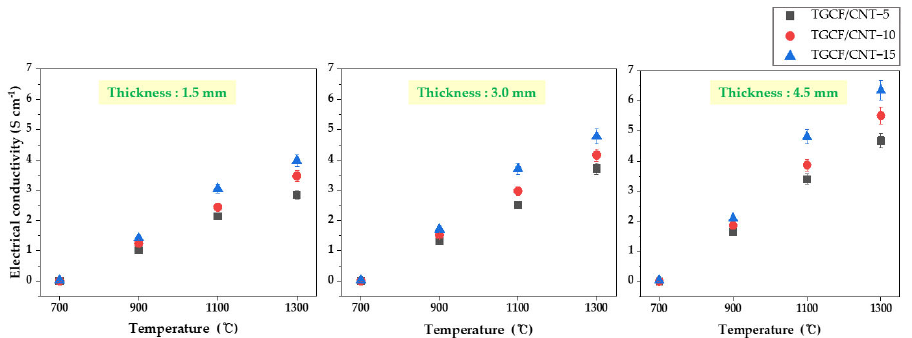
Figure 1. Electrical conductivity of TGCF/CNT carbon papers with various carbonization tempera- tures, thicknesses, and the CNT content.